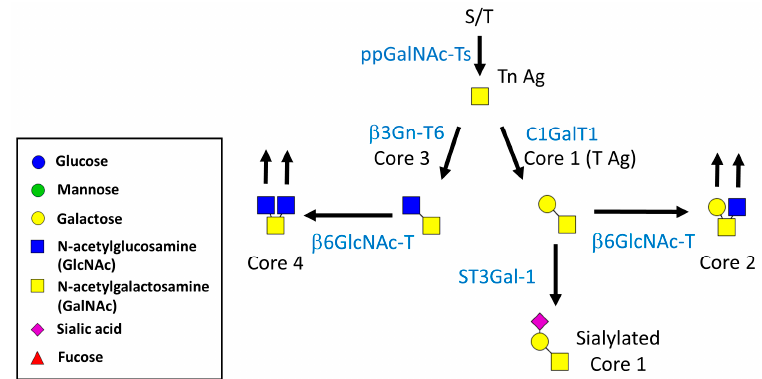
Figure 2. An overview of the mucin-type O -glycans. Mucin-type O -glycans are modified with a GalNAc sugar at the hydroxyl group of serine or threonine residues of proteins by ppGalNAc-Ts. The addition of galactose and GlcNAc results in the formation of the core 1 and core 3 structures, respectively. These core structures can be catalyzed by β 6GlcNAc-Ts, which add GlcNAc in α 1,6-linkage to the extant GalNAc (core 2 or core 4 structures). These glycans can be modified further via linear or branched structures through the addition of other sugars, such as galactose, GlcNAc, fucose, and sialic acid. Additional structural modification via addition of sialic acid, fucose, GlcNAc and Gal is not shown.